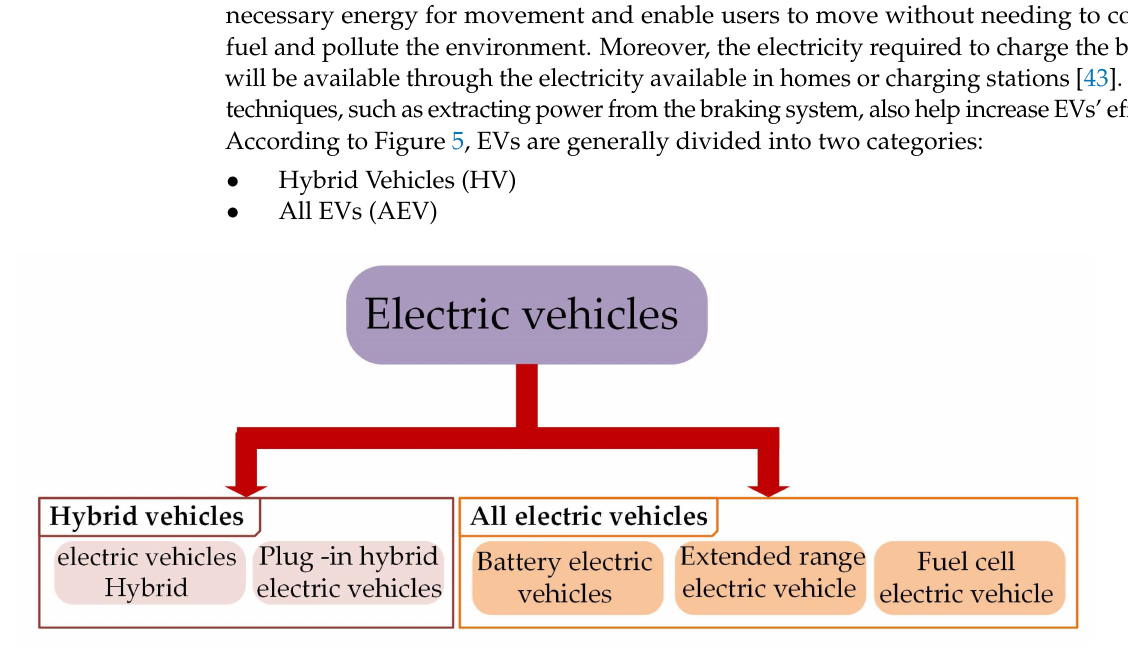
Figure 5. Classification of HV and AEV